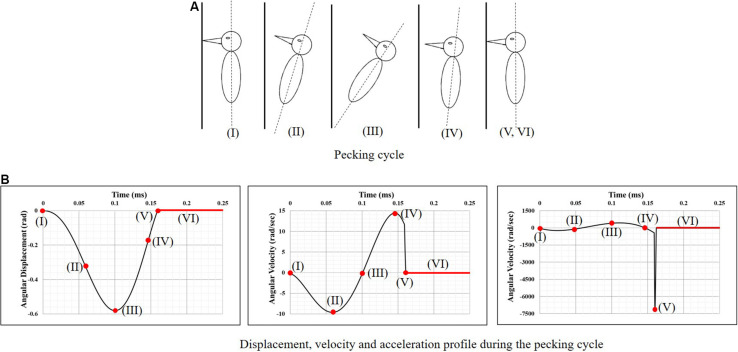
Woodpecker’s head kinematics during the pecking cycle. (A) Pecking cycle and (B) displacement, velocity and acceleration profile during the pecking cycle (Vincent et al., 2007).